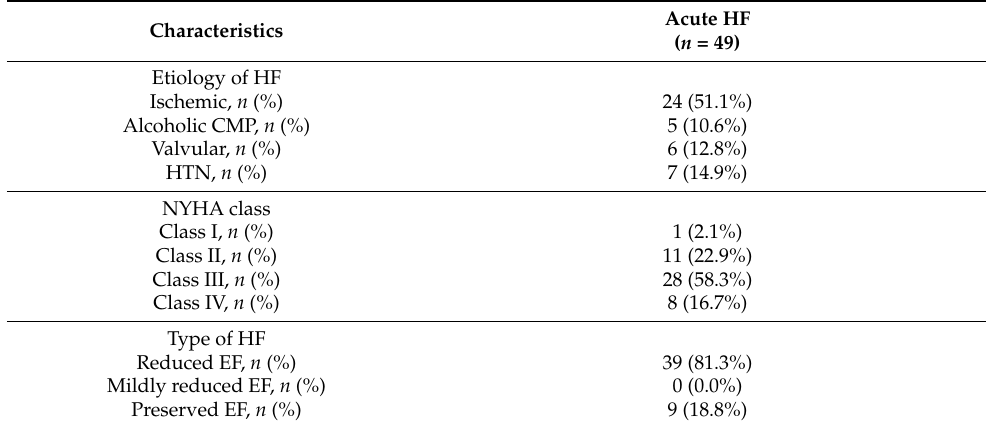
Table 4. Characteristics of acute HF patients.